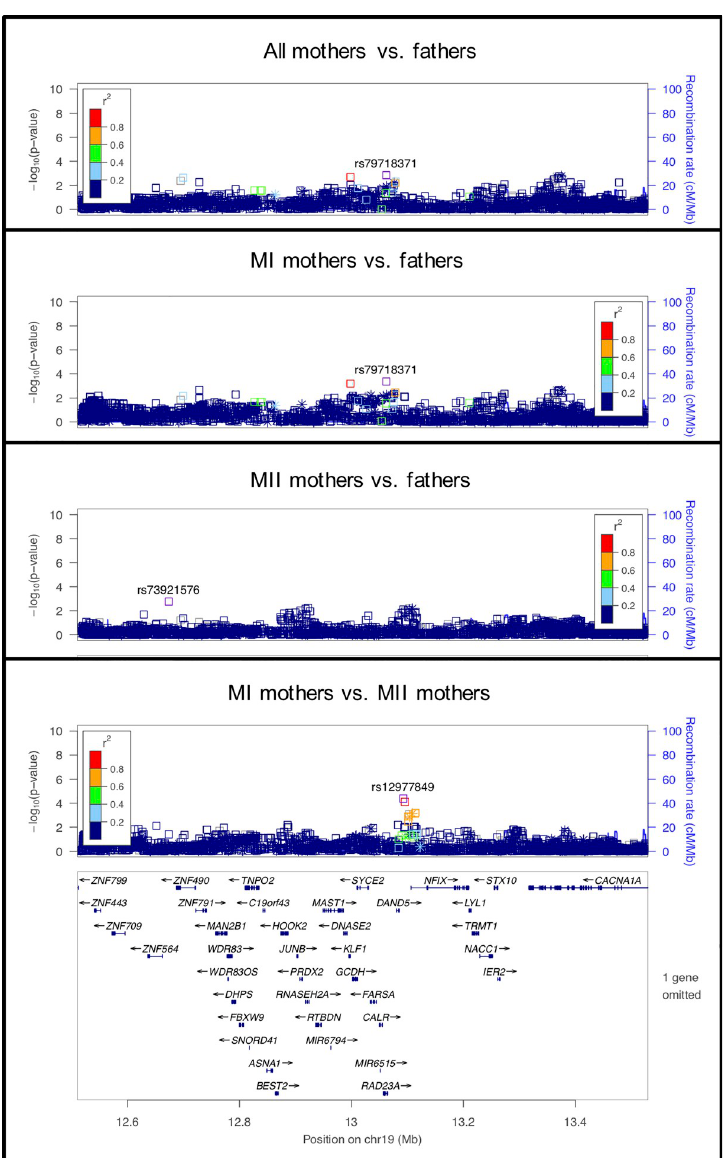
Fig 3. LocusZoom plot for SYCP1